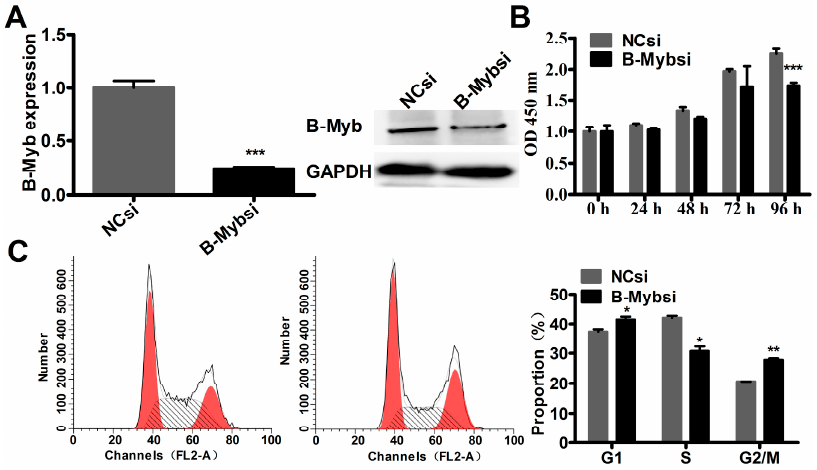
Figure 3. Knockdown of B-Myb inhibits lung cancer cell proliferation and cell cycle progression.